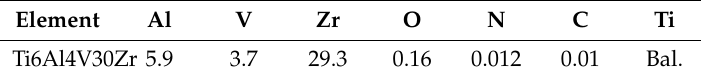
Table 3. The chemical composition of titanium ingot (balance Ti,